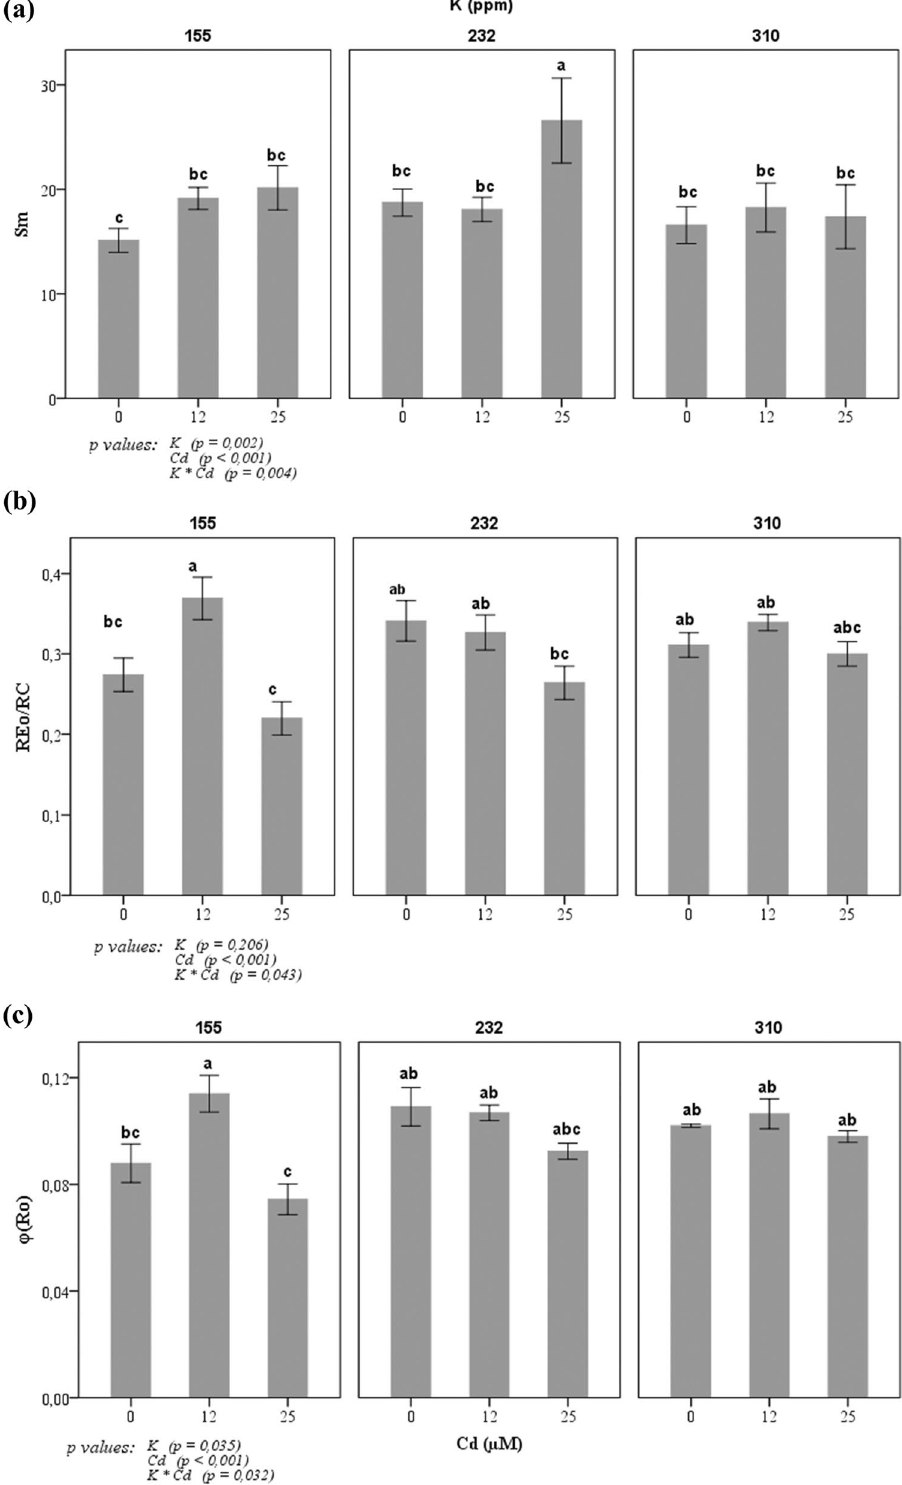
Figure 6. Effects of potassium concentration (155, 232, and 310 ppm) and three cadmium concentrations (0, 12 and 25 µM CdCl 2 ) on Chlorophyll a fluorescence parameters of tomato plants. ( a ) Sm is a function of the number of electrons transported by PS II in the time range from 0 to tF M , the time to reach the maximum fluorescence intensity. ( b ) φ Ro is the efficiency with which an electron can move from the reduced intersystem electron acceptors to the PSI end electron acceptors. ( c ) RE o /RC expressed the electron transport from Q A− to the PSI electron acceptors. Each value represents the mean ± SD of six independent repetitions, dissimilar letters indicate significant differences at p < 0.05 according to Student–Newman–Keuls